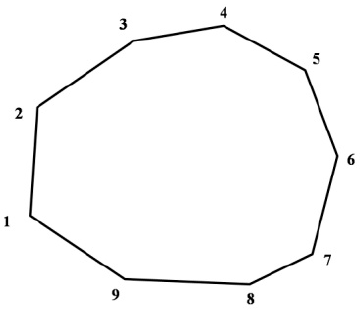
Figure 5. A sketch map with nine nodes.